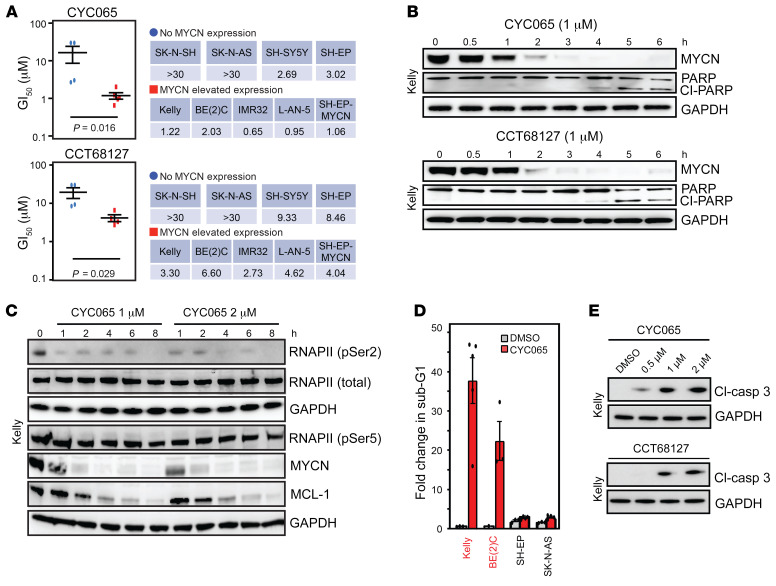
CDK9 and CDK2 are selectively essential for MYCN-amplified NB.(A) GI50 of CCT68127 and CYC065 in a panel of NB cells. Cells were treated for 8 hours, washed off, and replaced with normal growth medium. GI50 values (μM) were calculated after 72 hours (n = 3). Significance was calculated using 2-tailed, unpaired Student’s t test. (B) Kelly cells were treated with CYC065 or CCT68127 for 0.5 to 6 hours (1 μM). Immunoblots illustrate expression of PARP cleavage (n = 2). (C) Immunoblots showing expression of p-RNAPII-Ser2 and p-RNAPII-Ser5, MYCN, and MCL-1 at the indicated times after treatment with CYC065 (1–2 μM, 1–8 hours) in Kelly cells (n = 2). (D) Flow cytometry analysis showing sub-G1 level of MYCN-amplified (Kelly, BE(2)C) and nonamplified (SH-EP, SK-N-AS) cells in response to CYC065 (1 μM; 8 hours). Data are represented as mean ± SD of 3 independent experiments. (E) Kelly cells were treated with CYC065 or CCT68127 at the indicated concentrations (0.5–2 μM) for 6 hours. Immunoblots depict expression of cleaved caspase-3 (n = 2).